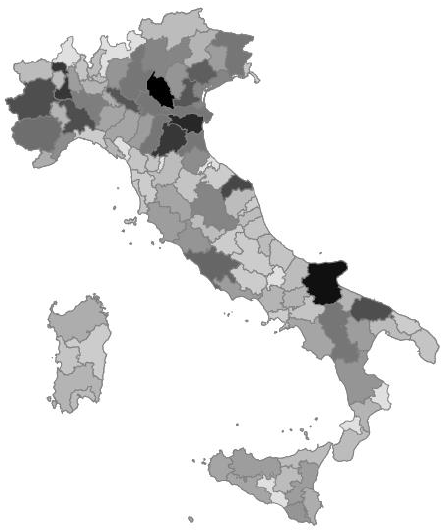
Figure 2. Geographical distribution of companies in the sample.